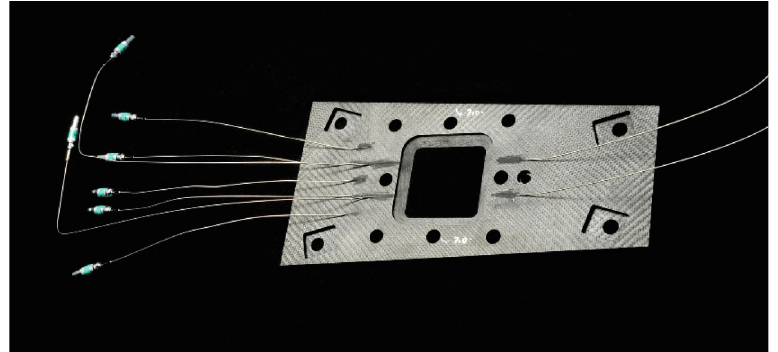
Figure 14: AKTiV panel